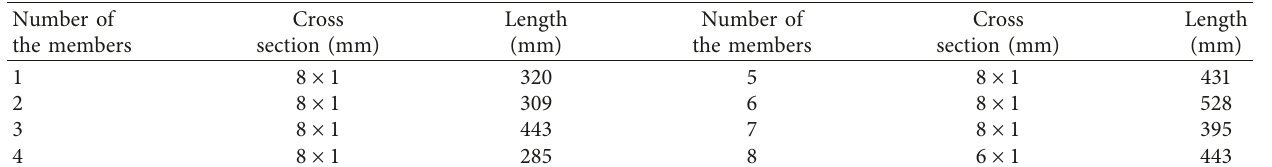
Figure 1: Details of the test structure. (a) The members and nodes of structure B1; (b) the members and nodes of structure B2; (c) structure B1 without isolation; (d) structure B2 with isolated supports. Table 2: Details of the circular pipe used in the test